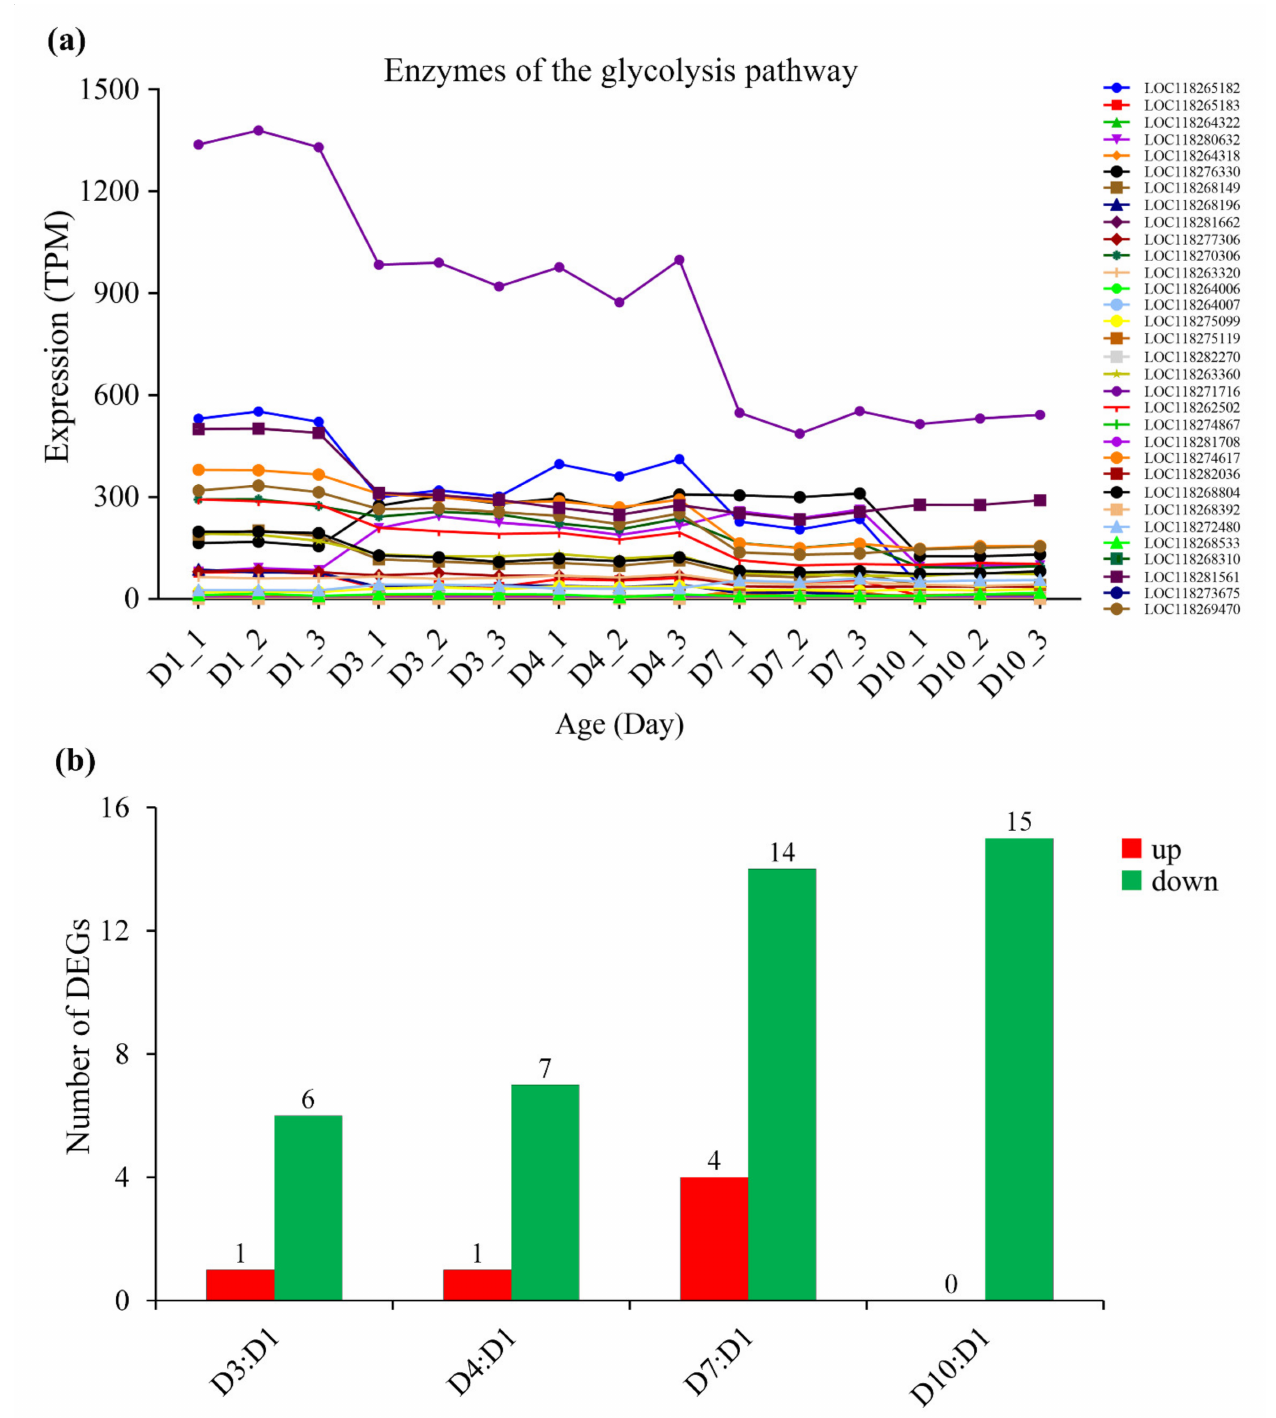
Figure 5. The expression of enzymes of the glycolysis pathway in S. frugiperda females at different ages. ( a ) Changes in enzyme gene expression with age; ( b ) DEGs of D3:D1, D4:D1, D7:D1 and D10:D1 groups, wherein red columns represent upregulated DEGs and green columns represent downregulated